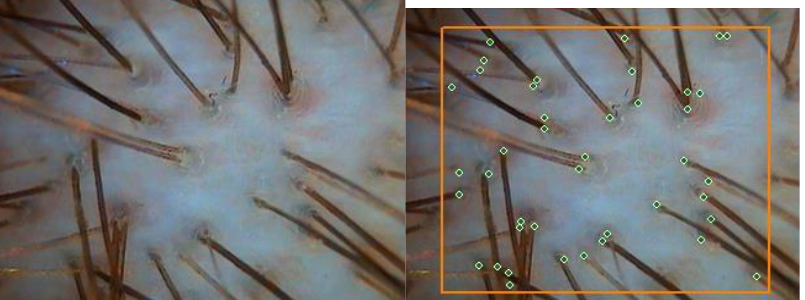
Figure 1. Determination of hair density. One cm 2 is bordered by the orange line. Magnification ×60. To assess average hair thickness, diameter of hairs (μm) was determined using a ×200 lens (Figure 2). The numbers in yellow squares indicate the hair diameter in μm.